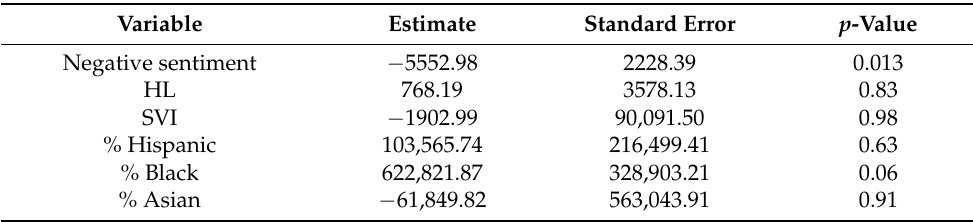
Table 3. The association between vaccination increase and negative